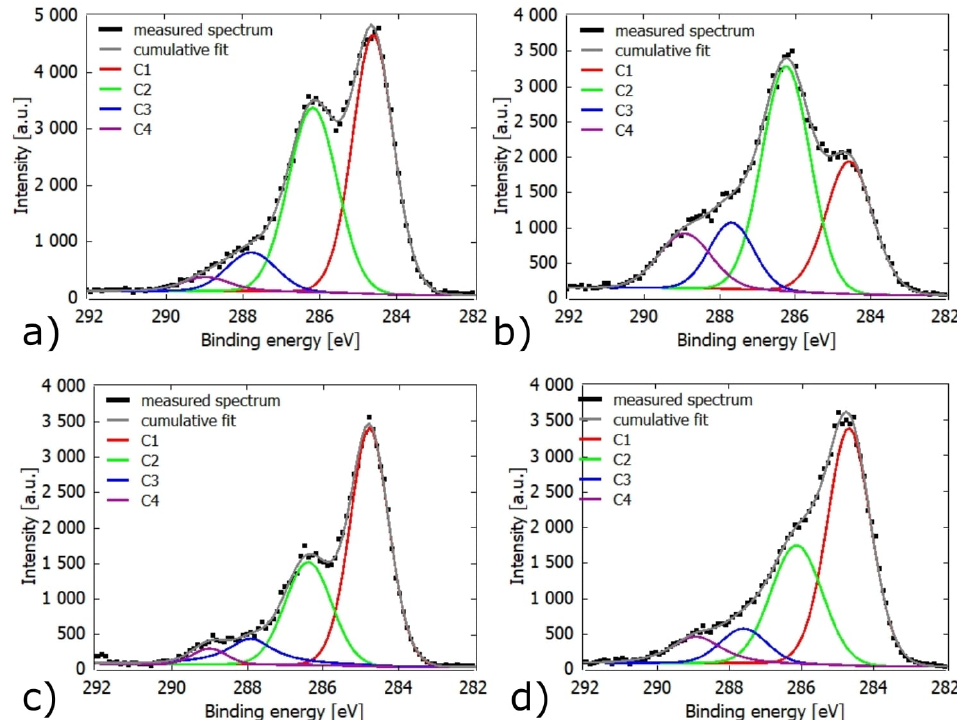
Figure 9. The XPS spectrum deconvolution of Cls band: ( a ) untreated Ref sample, ( b ) Ref sample plasma treated in the air at 0,15 mm gap ( c ) Ref sample plasma treated in the air at 1 mm gap, ( d ) at 0.15 mm gap ( c ) Ref sample plasma treated in the air at 1 mm gap, ( d ) T200 plasma treated at 1 mm T200 plasma treated at 1 mm gap.